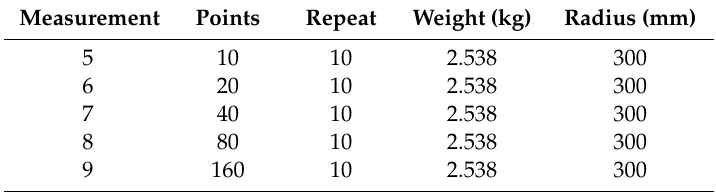
Table 6. Parameters for measurements of the influence of the radius dimension.